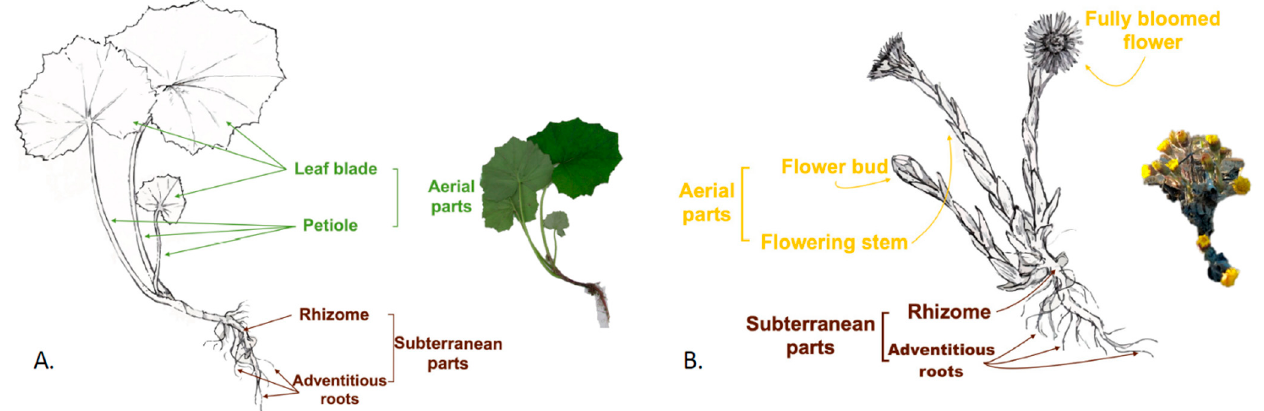
Figure 1. Morphology of T. farfara in: ( A ) vegetative form; ( B ) reproductive form. Note: original figure is not to scale.